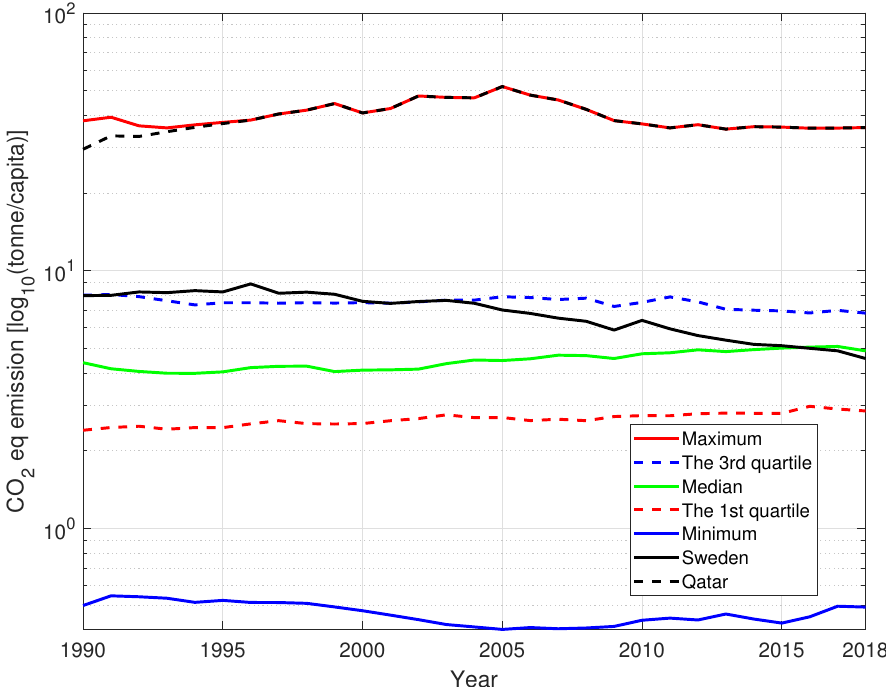
Figure 4. Percentile plot of total GHG emission per countries. Based on country emissions data, percentile values can be calculated each year to obtain the maximum, the third quartile, median, first quartile, and minimum functions. The figure can be used to determine the role of a country in damaging the environment. In this example, Qatar has the highest damaging potential during the past few years. However, Sweden has reduced the GHG emission significantly from the third quartile to the